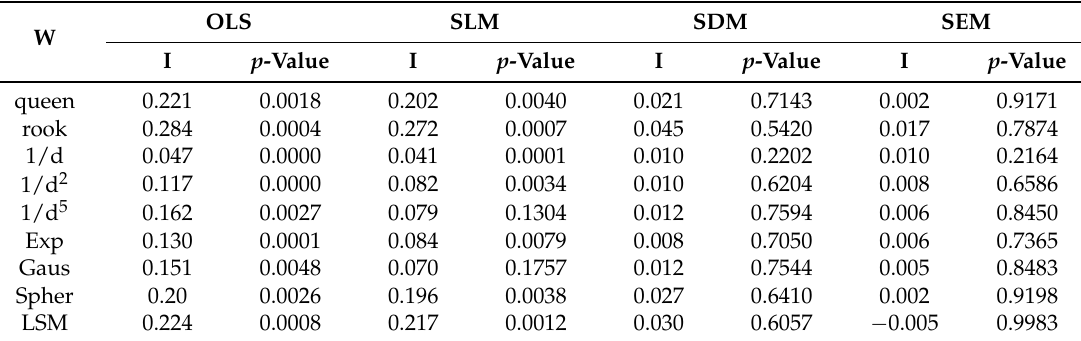
Table 2. Moran’s I of four model residuals for nine spatial weight